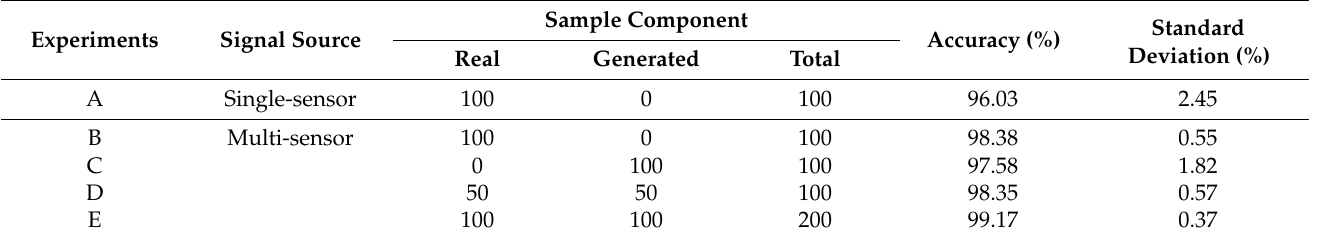
Table 5. Experimental setup and results for evaluation of the generated samples.